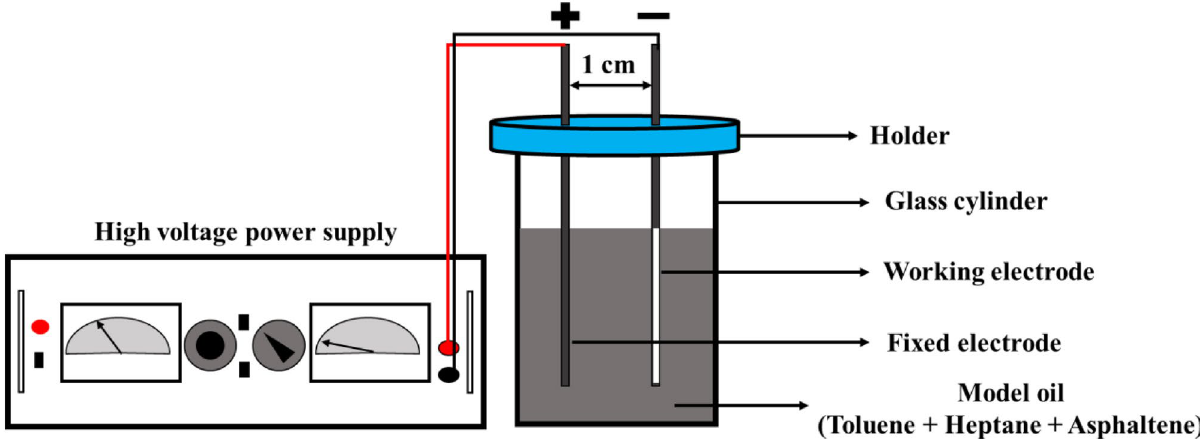
Figure 3. A schematic of the electrodeposition